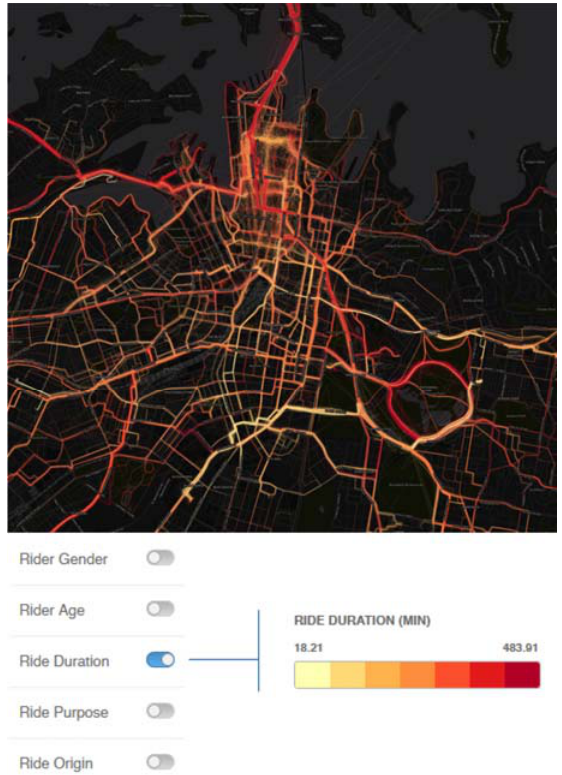
Figure 6. Sydney Area Rider Routes by Rider Duration